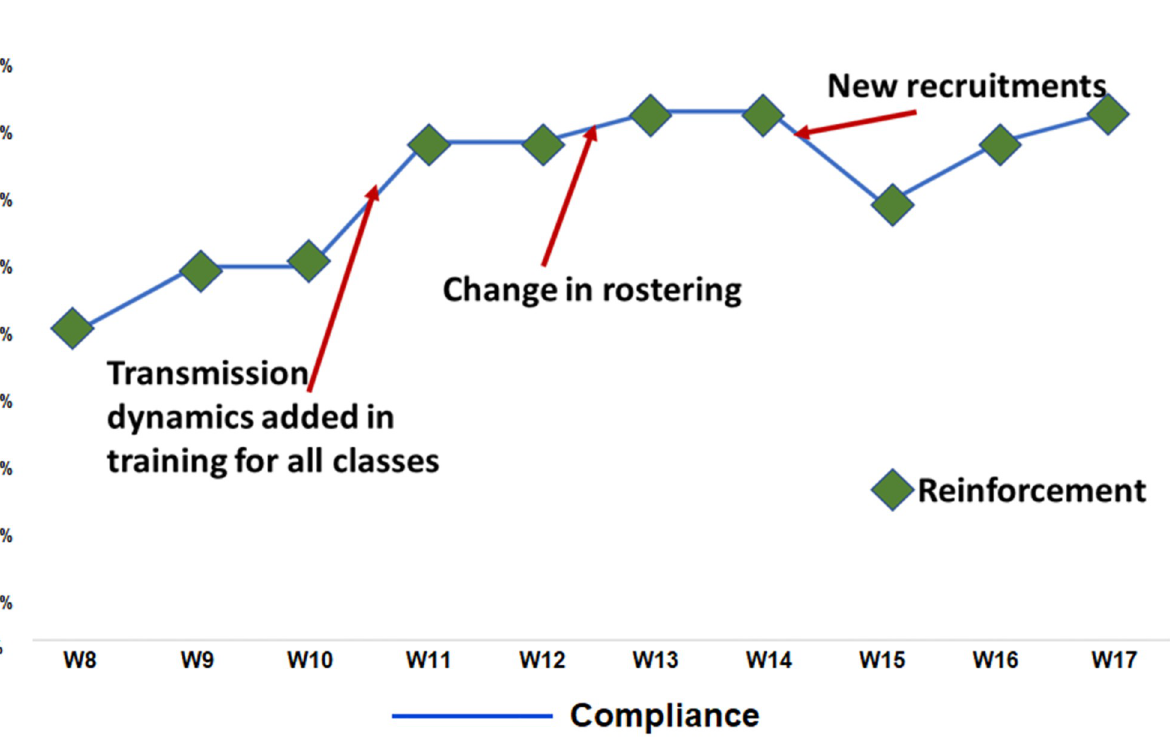
Fig 4. Compliance trends to the surface disinfection related activities (W8 in the figure stands for the first week of the month of May 2020).